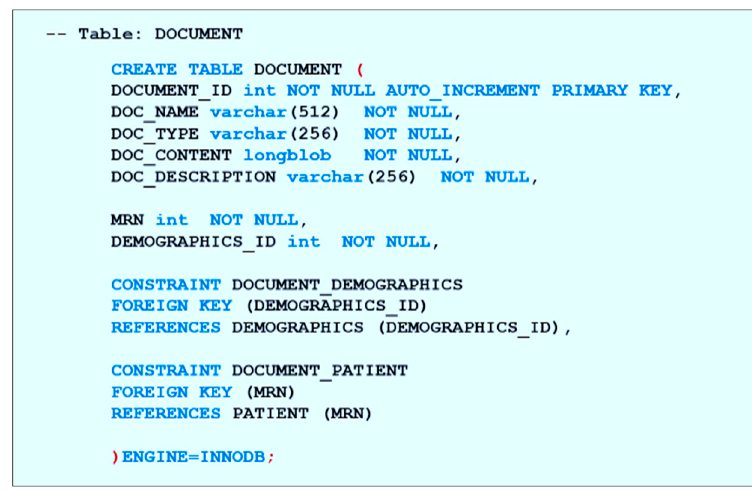
Figure 13. SQL script for using “LONGBLOB” data type in the “DOCUMENT” table.